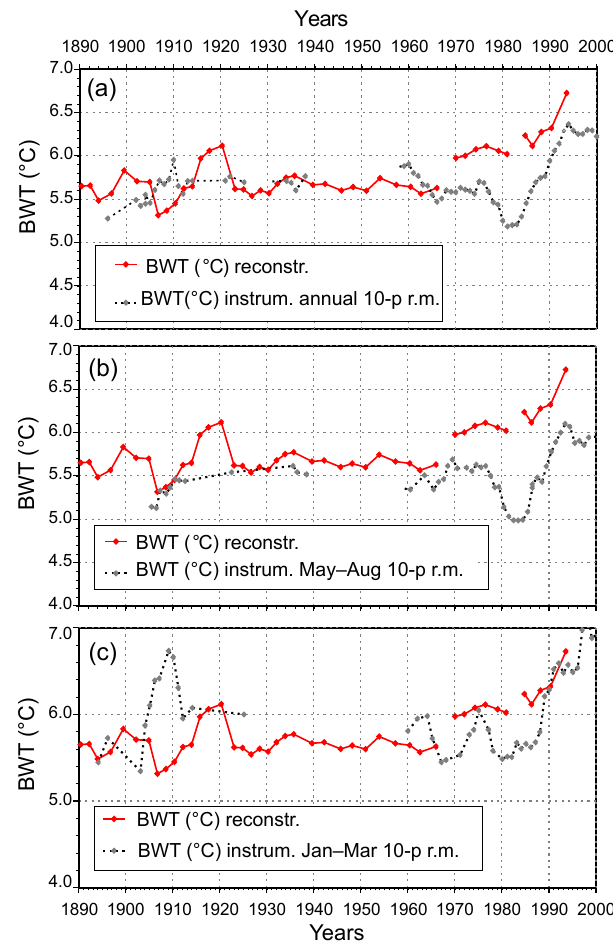
Figure 7. Comparison of the winter bottom water temperatures (BWT) reconstructed from the Gullmar Fjord record to instrumen- tal basin water temperatures measured in the deepest fjord basin: the annual mean (a) , the mean for May–August (b) and the mean for January–March (c) . All instrumental BWT curves (black) are shown as 10-point running means (10-p.